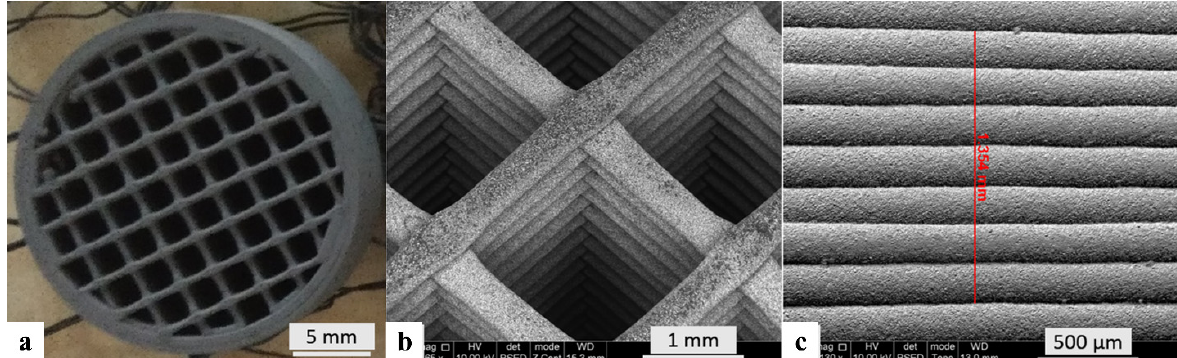
Figure 9. An as-printed part fabricated by metal MEX process, using an in-house developed 316L filament: ( a ) overview of the as-printed part, ( b ) top view and ( c ) side view (adapted from [83]).